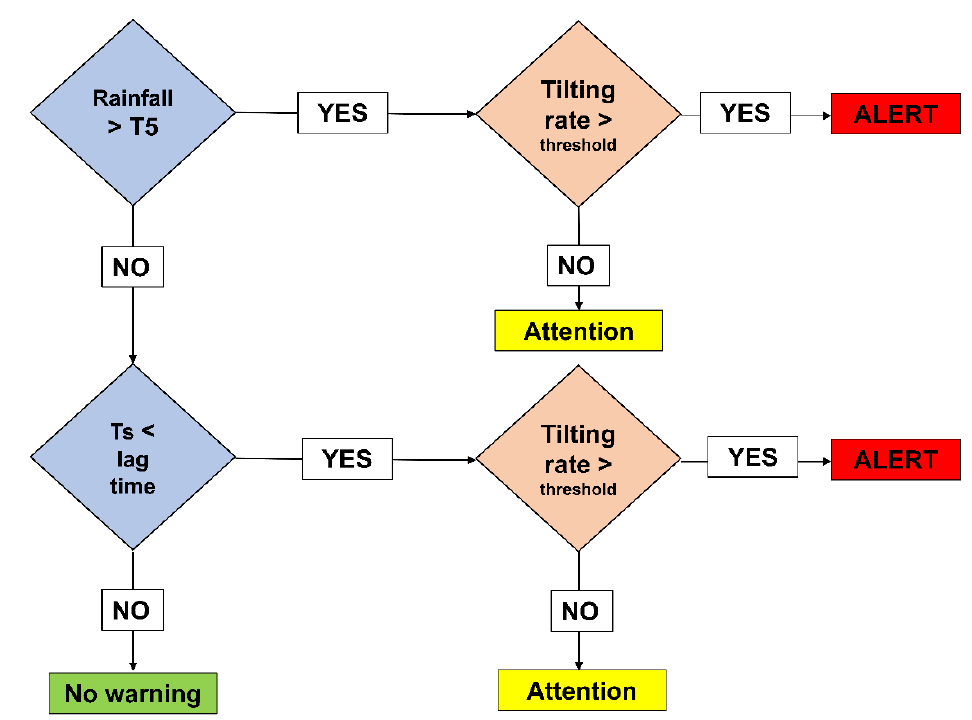
Figure 9. Proposed algorithm for issuing slope failure alert in Chibo area, Kalimpong.